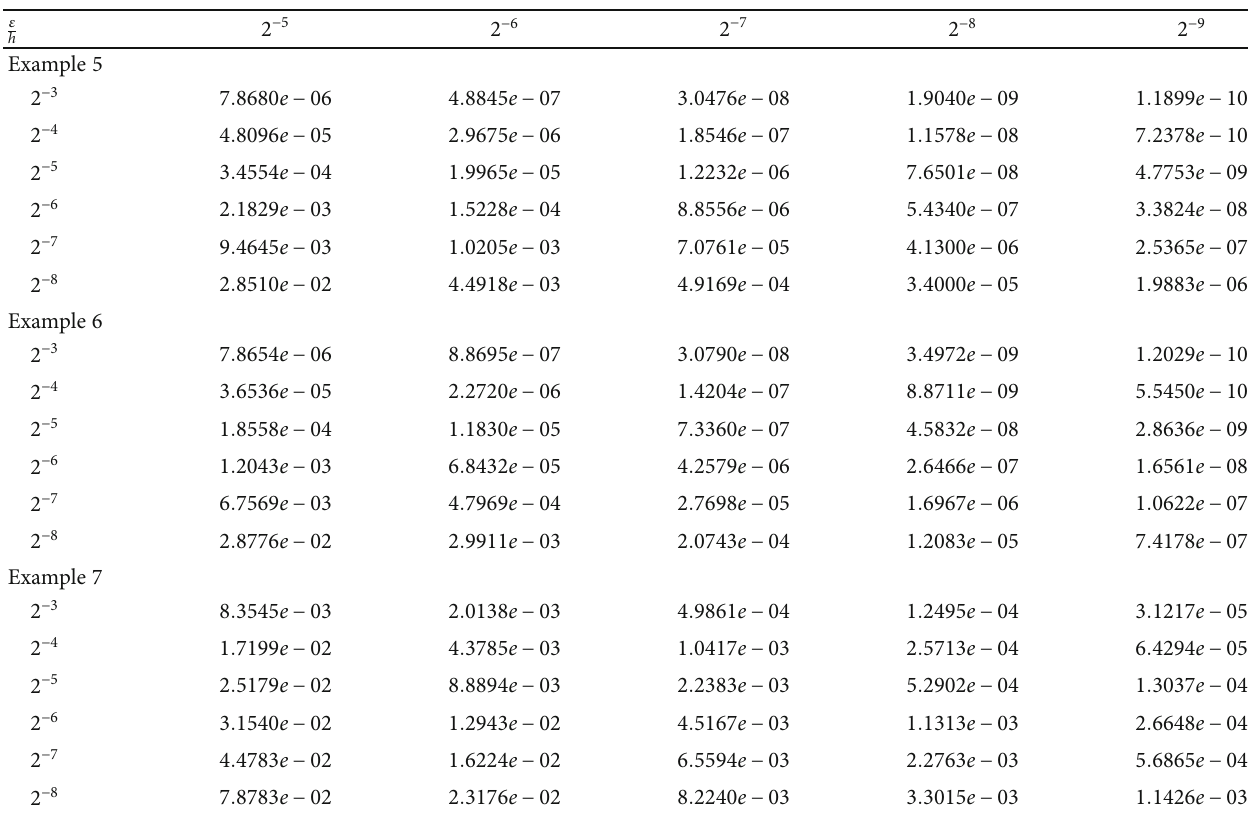
Table 6: Maximum absolute error for δ , η = 0 : 5 ε